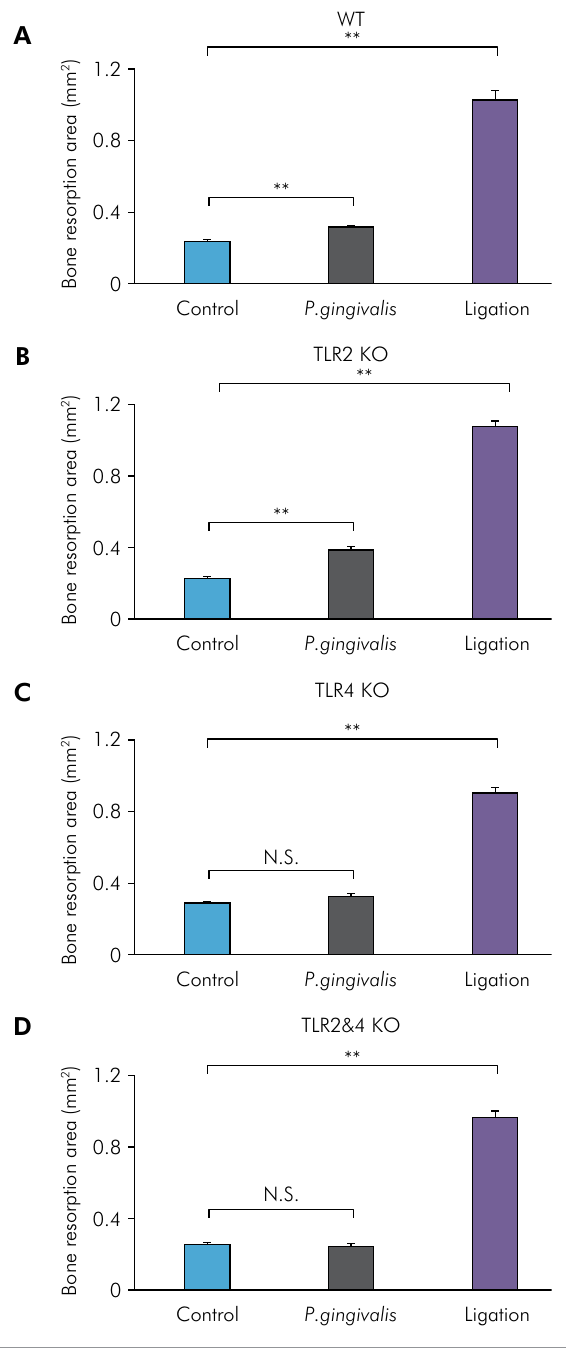
Figure 2. Bone resorption analysis of P. gingivalis -induced and ligation-induced experimental periodontitis in WT, TLR2 KO, TLR4 KO, and TLR2&4 KO mice. The bone resorption area of P. gingivalis -induced and ligation-induced experimental periodontitis was measured and analyzed with ImageJ software on buccal and palatal surfaces in WT mice (A), TLR2 KO mice (B), TLR4 KO mice (C), and TLR2&4 KO mice (D) (means ± SE, n = 5 mice per group, **p < 0.01, N.S. = no significant difference). For each segment, a standard calibrator was used for calibration at the same magnification for all